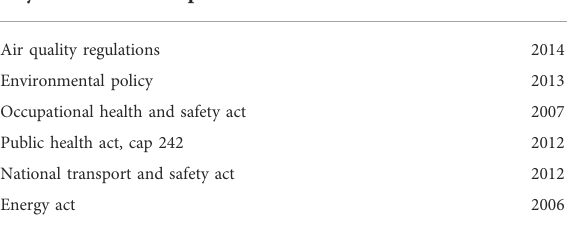
TABLE 1 Key environmental policies related to air quality in Kenya (UNEP,